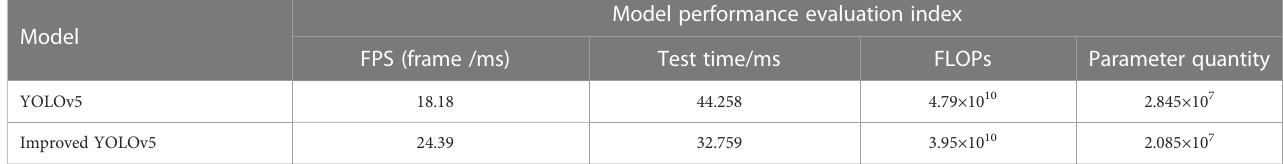
TABLE 3 Comparison of performance evaluation indexes of different models.